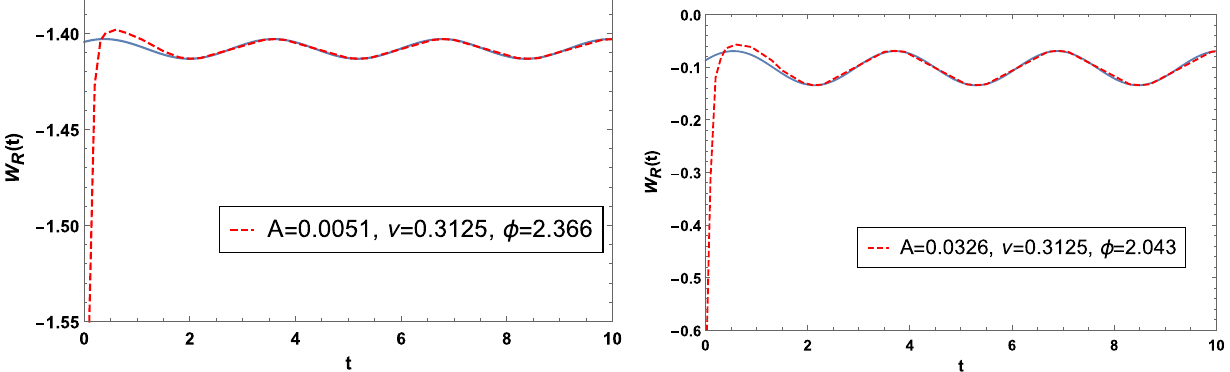
Fig. 3 W R ( t ) in terms of the boundary time t for l = 1, k = 0 . 3 and μ / T = 0 . 1. For the left (right) graph μ f f T f = 0 . 1340 ( 0 . 2200 ) . The static potentials for left (right) graph is